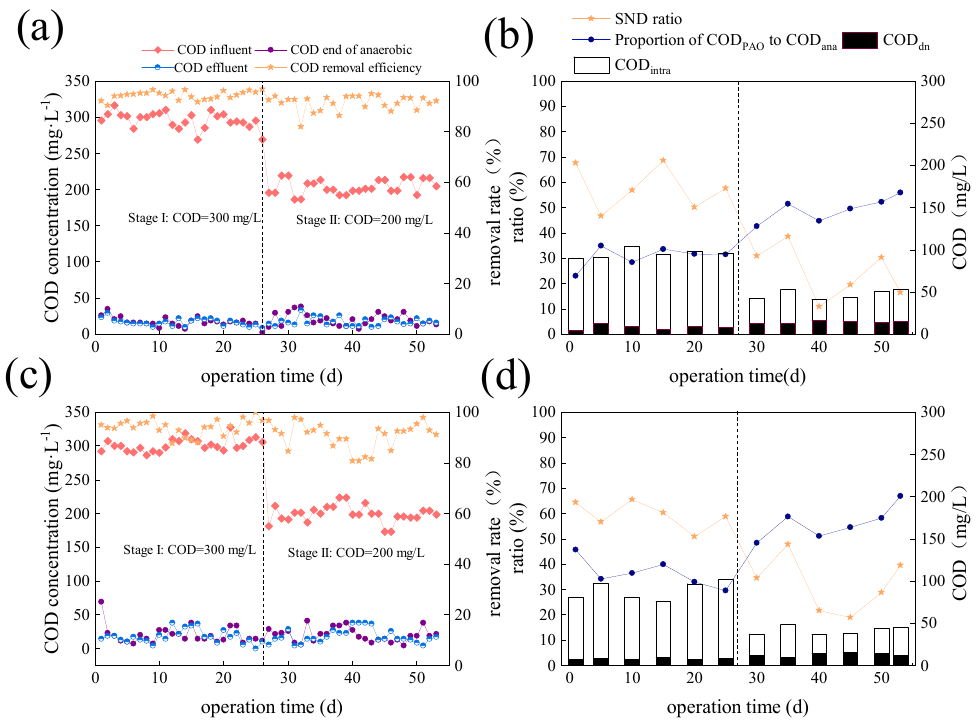
Figure 1. Organic matter removal and the COD intra , COD dn and SND ratio in SNDPR system with different COD concentrations in influent. (( a , b ): 100 kPa; ( c , d , b ): 72 kPa).